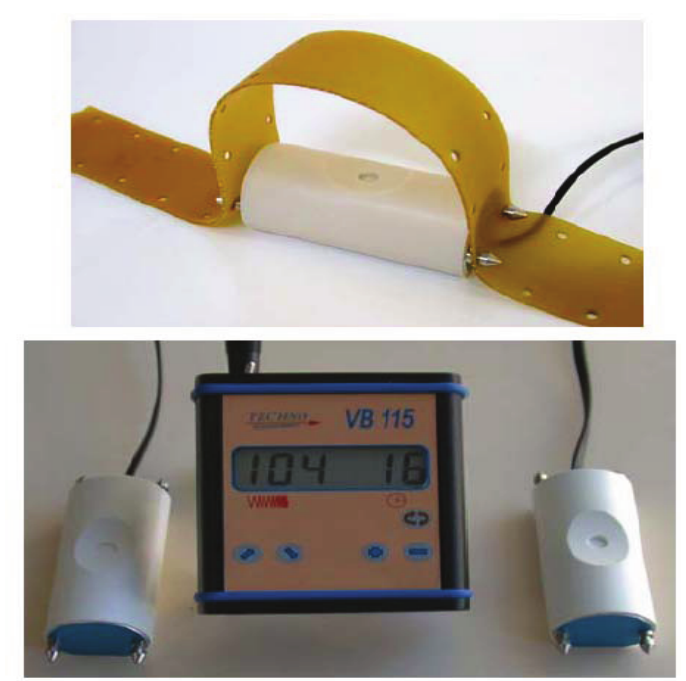
Figure 1. The VB 115 tendon vibration system. The vibrating cylinders were attached to subject’s tibialis anterior tendons using the rubber strap shown